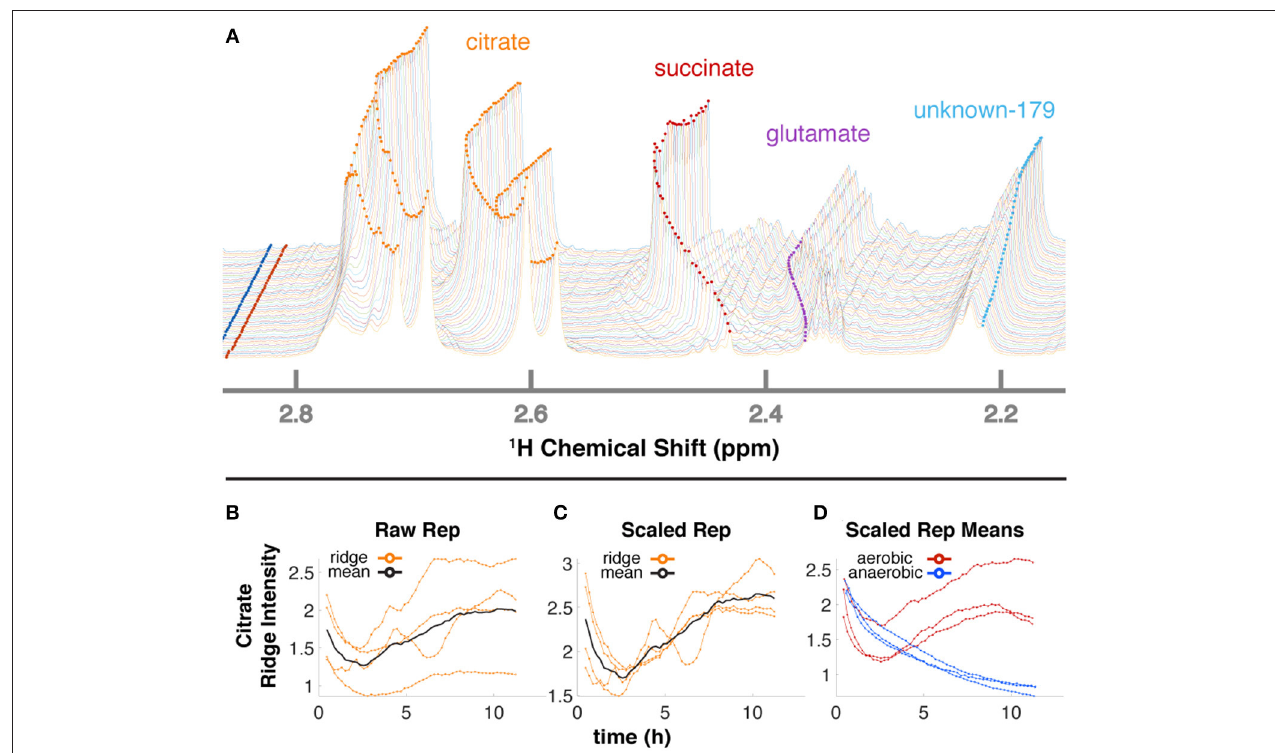
FIGURE 4 | Ridge tracing produces concentration dynamics of metabolites. (A) Multiple traced ridges for a single aerobic replicate. Peak maxima at each time point were located using a peak-picking algorithm that includes an adjustable Gaussian filter. Maxima were connected to form ridges along the time dimension using a single linkage hierarchical agglomerative clustering based on Euclidean distances between the points in chemical shift, time, and intensity space. Metabolites typically have several characteristic NMR peaks, e.g., the 4 orange ridges in citrate (A) . A simple time-wise average represented by the black line in (B) only gives the average intensity over time but loses valuable information on actual dynamic trends. To more accurately extract trends for a particular metabolite, we first integrate each peak in that metabolite over time to obtain its mean value. Then, each peak trajectory is scaled by ratio of the highest mean to its own mean, yielding the 4 orange lines in (C) . The mean of these trajectories is shown in black in (C) and represents the relative concentration over time for that metabolite in that replicate. The 3 aerobic (red) and 3 anaerobic (blue) replicates for citrate are shown in (D)